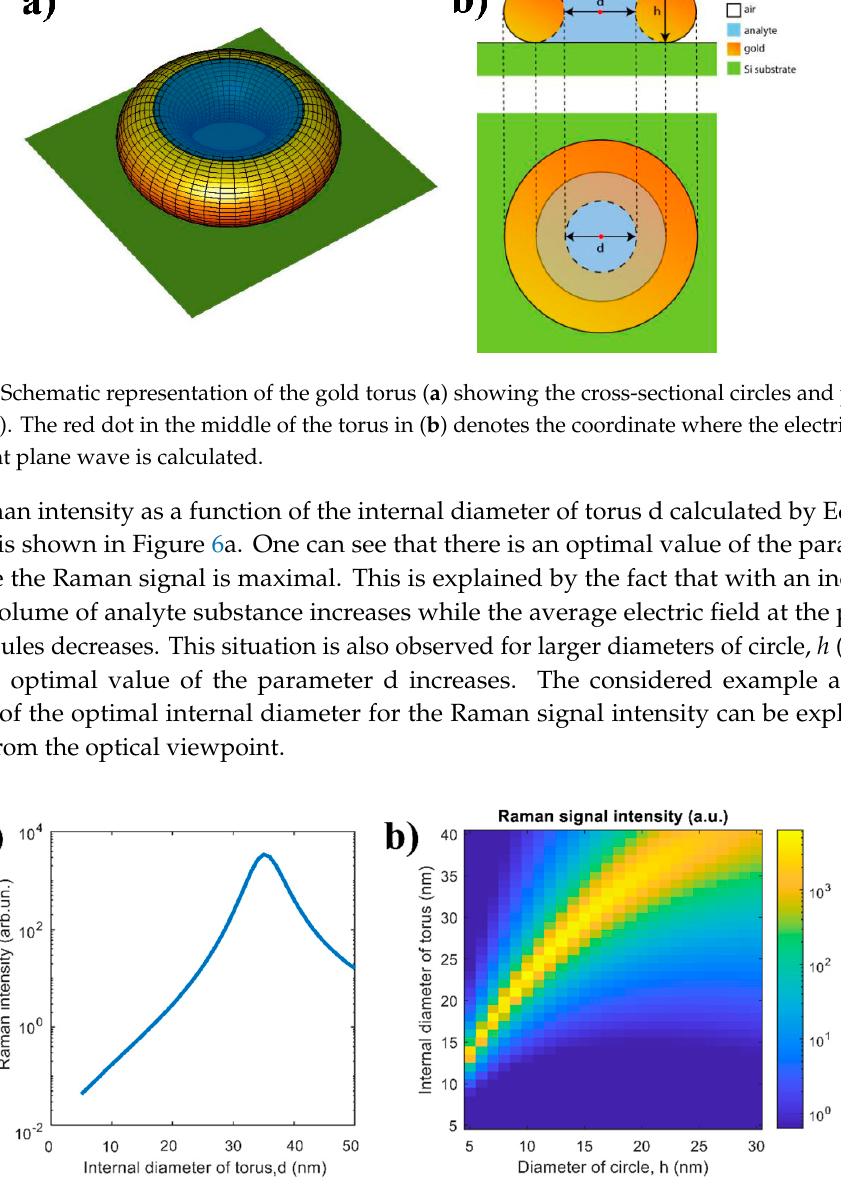
Figure 6. Theoretical dependence of the Raman signal intensity ( a ) on the internal diameter of torus d calculated as h = 20 nm and ( b ) on both parameters d and h .